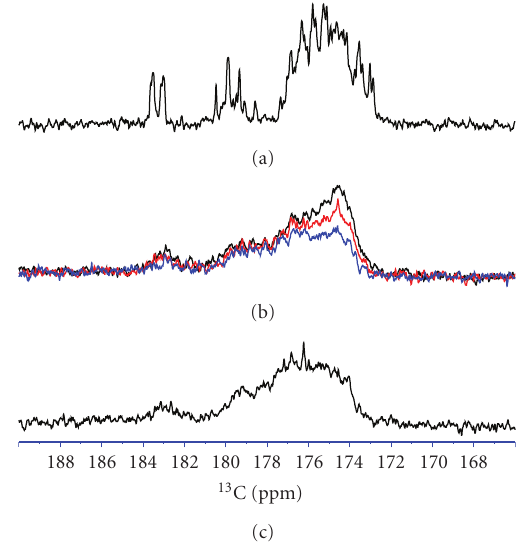
Figure 3: Carbonyl 13 C spectra of uniformly 13 C-labelled A β (1–40). Spectral data were obtained using 0.2 mM A β (1–40) titrated with GM1 micelles at A β /GM1 molar ratios of (a) 1 :0, (b) 1:15, and (c) 1: 30. In (b), the spectra measured in the presence of ThT are displayed at A β /ThT molar ratios of 1:0 (black), 1 :1 (red), and 1:2 (blue).